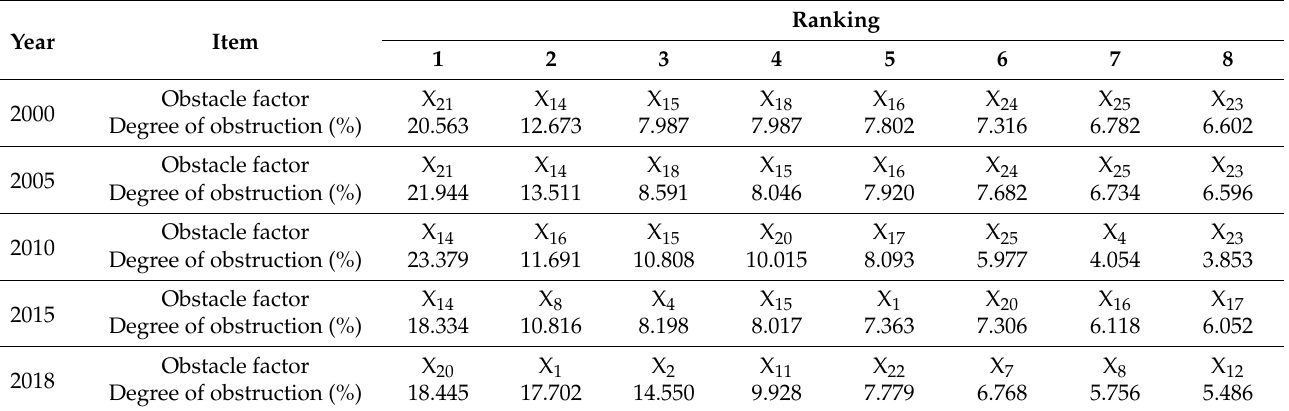
Table 4. Ranking of Obstacle factors of